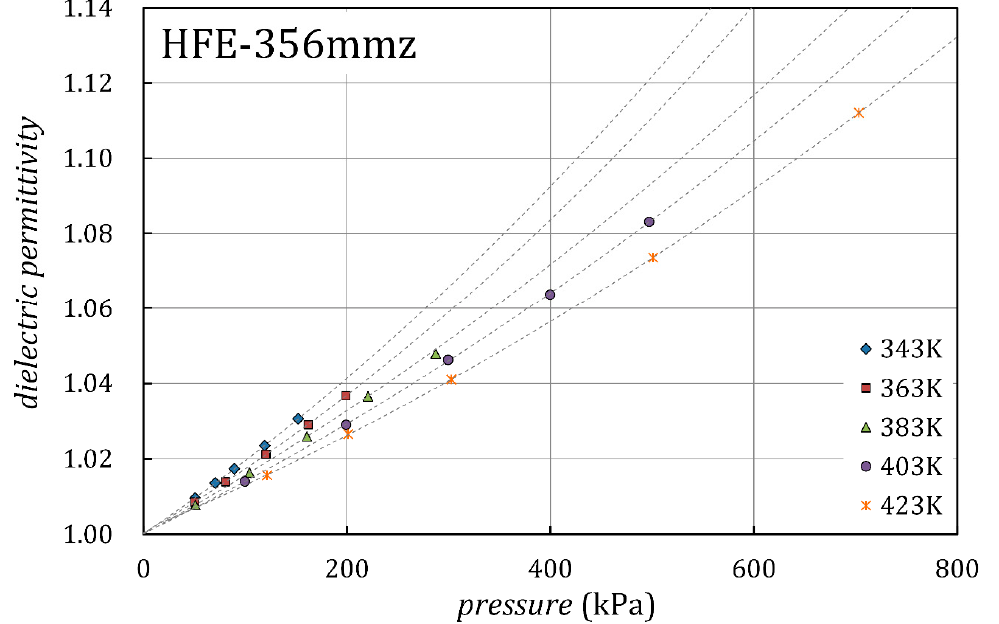
Figure 4. Dielectric permittivity data on five isotherms for HFE-356mmz.